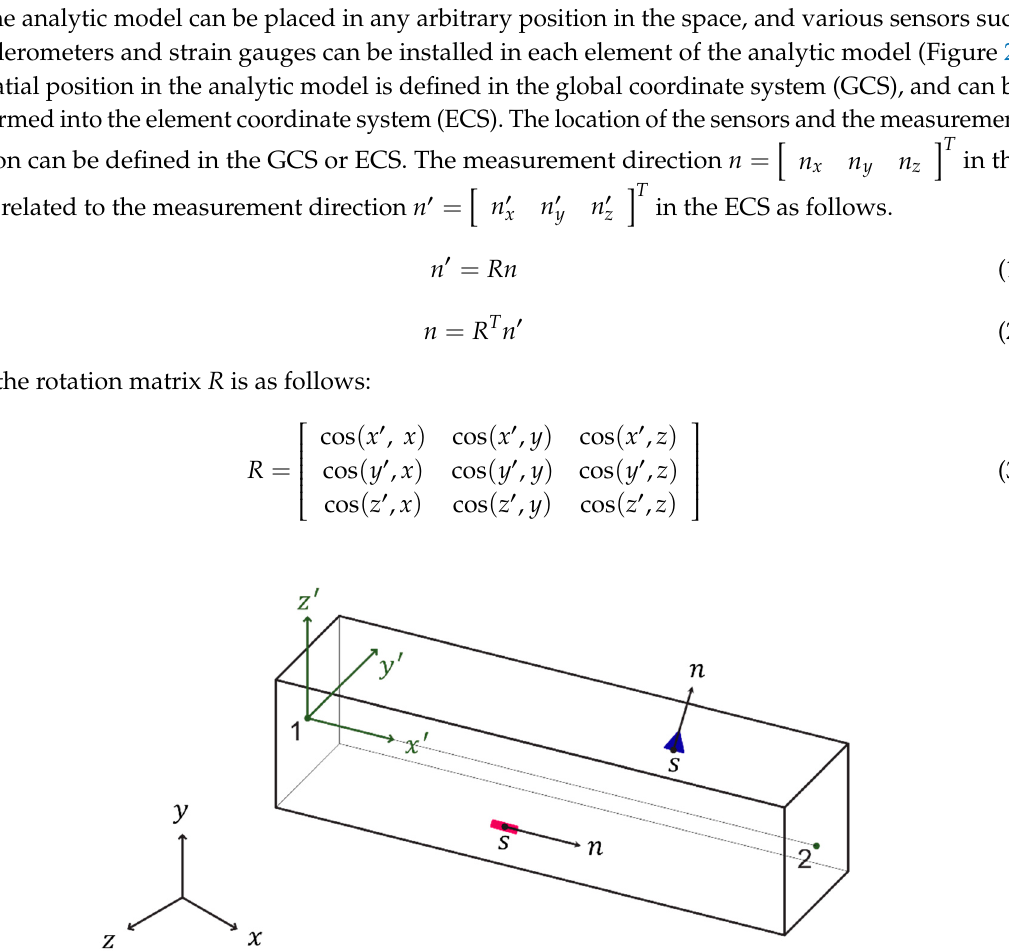
Figure 2. Relationship between the global coordinate system and element coordinate system.